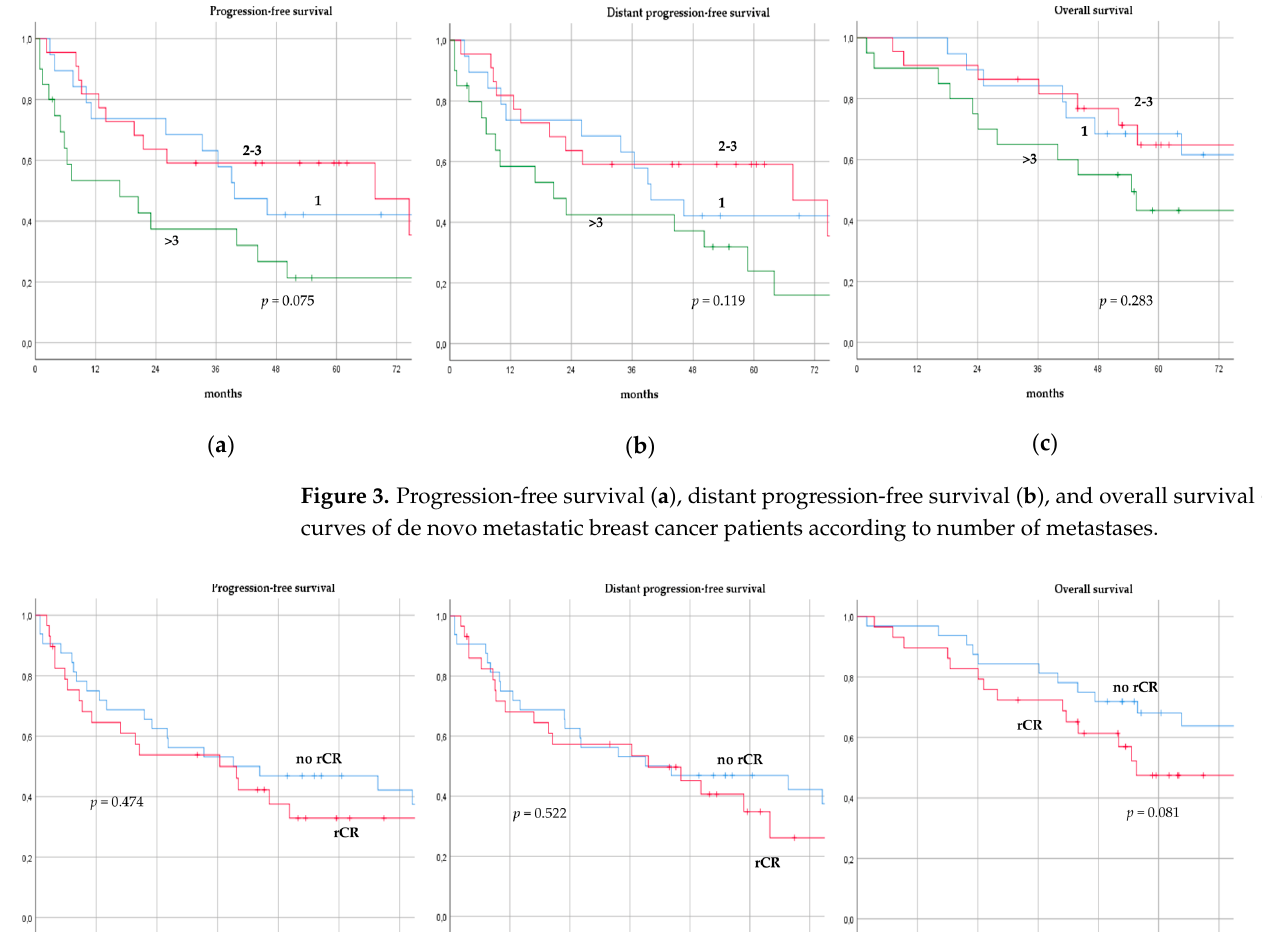
(c) Figure 5. Progression-free survival ( a ), distant progression-free survival ( b ), and overall survival ( c ) curves of de novo metastatic breast cancer patients according to biological sub-type. TP: Triple- positive, HER2+: HER2-enriched, TN: Triple-negative. 4. Discussion In this small retrospective cohort analysis, we sought to disclose the long-term oncological outcomes of de novo MBC patients undergoing FLC followed by LRT and to determine the potential existence of a subgroup of metastatic patients who might benefit from surgery. Our results suggest that there is no statistically significant survival advantage in any subgroup of de novo MBC patients, regardless of their menopausal status, surgical treatment, biological sub-type, location, number, and rCR of metastases. However, we observed a slight trend toward better recurrence outcomes in triple-positive tumors. Stage IV breast cancer is considered an incurable systemic disease and survival is mainly determined by the progression of metastases [22]. Until now, systemic therapy, including chemotherapy, anti-HER2-targeted therapy, and/or endocrine therapy, remains the mainstay of treatment. The role of LRT remains controversial and is usually reserved only for patients with impending complications, such as skin ulceration, bleeding, fungation, and pain [4,23]. Despite these recommendations, the benefit of LRT in this population has long been debated and a vast number of MBC patients still undergo surgical resection of the primary tumor [14,22]. Khan et al. [24] examined the use of local